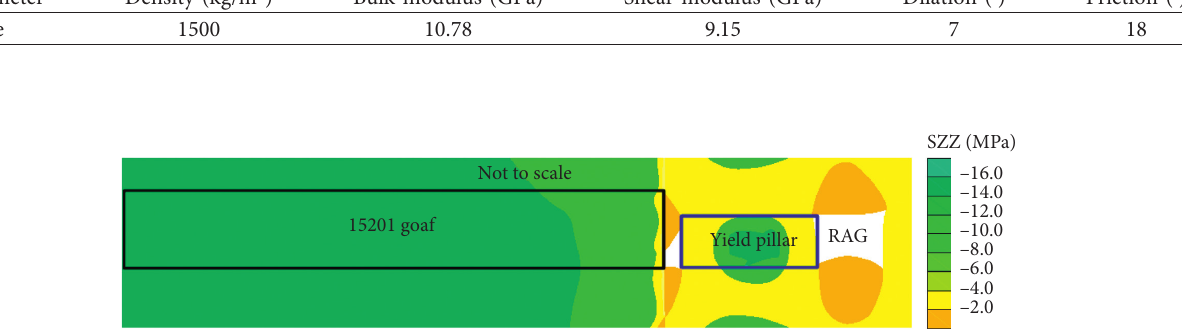
Figure 10: Mining-induced vertical stress of the panel 15201 goaf.